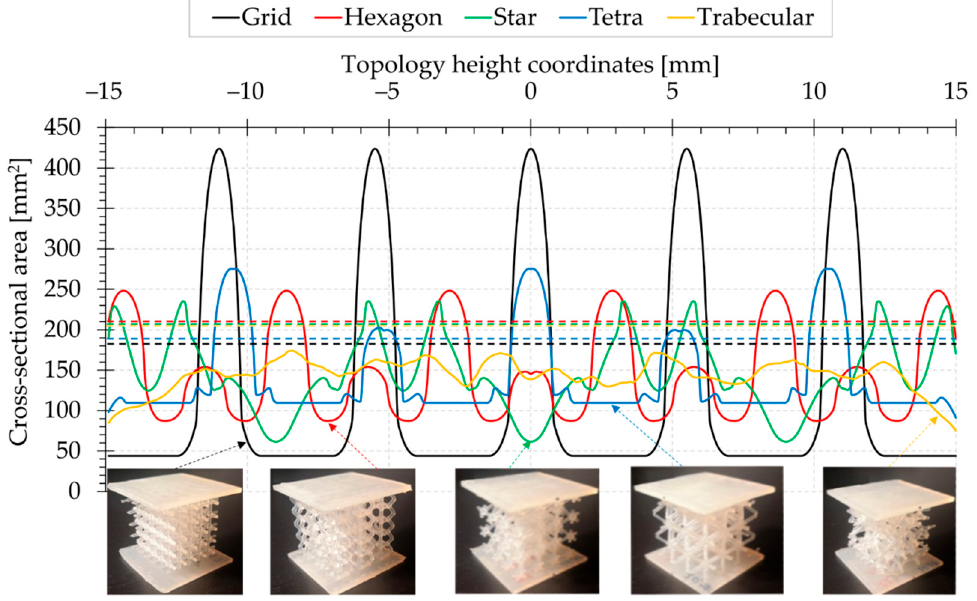
Figure 3. Cross-sectional area variation of the topology along the height, excluding faceplates. The dashed lines indicate average values.